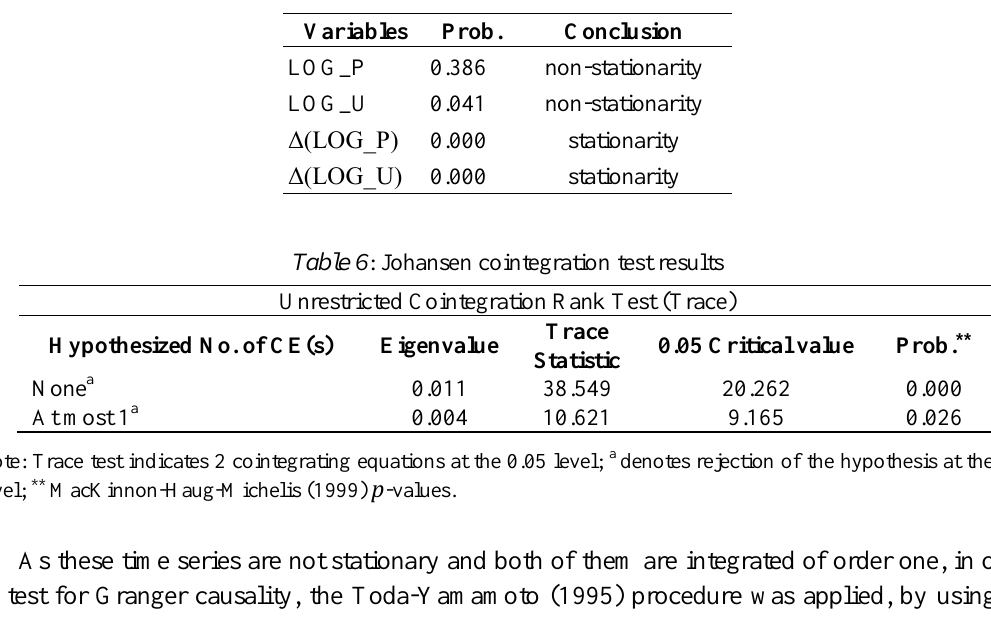
Table 5 : ADF test results at 99% confidence level